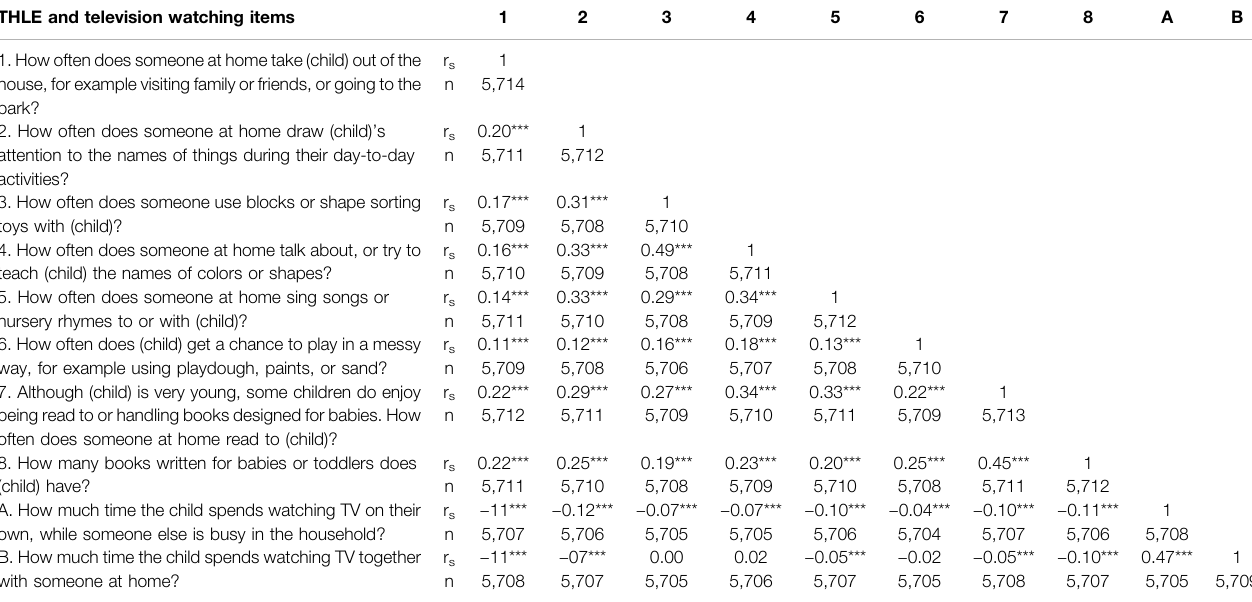
TABLE 3 | Bivariate associations between the eight items measuring the Toddler Home Learning Environment and two items measuring toddlers ’ television watching environments (Spearman ’ s Correlations, r s ) THLE and television watching